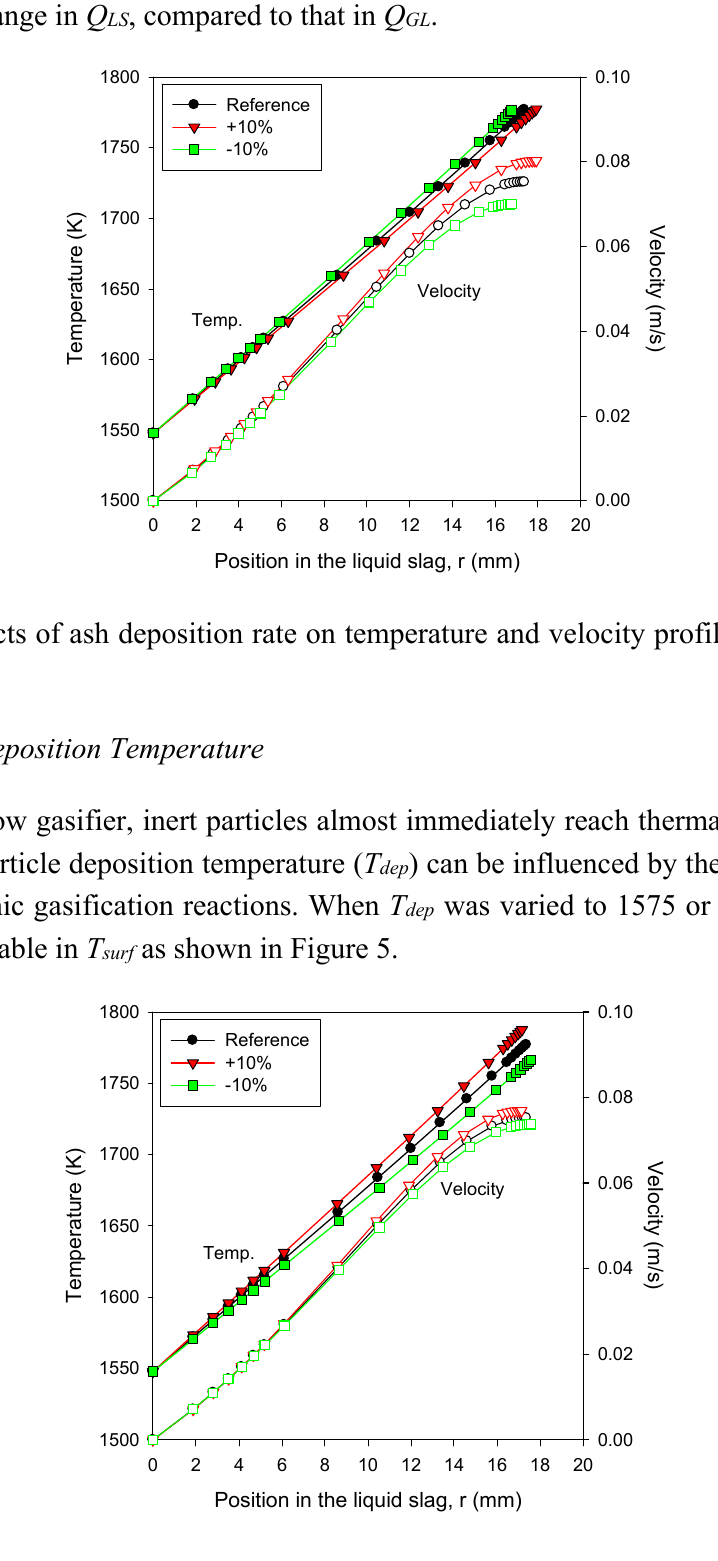
Figure 5. Effects of ash deposition temperature on temperature and velocity profiles of liquid slag at the slag